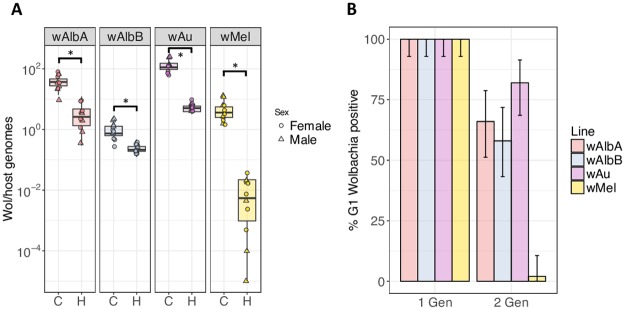
High temperature results in reduced Wolbachia densities and maternal leakage.(A) Larvae from the wAlbA, wAlbB, wAu, and wMel strains were reared at constant 27°C (C) or with temperature fluctuating between 27–37°C (12hours:12hours) (H) and assessed for Wolbachia density by qPCR upon adult emergence. Each point represents a pool of 3 adult mosquitoes. The centre of a box plot shows median Wolbachia density, edges show upper and lower quartiles, and whiskers indicate upper and lower extremes. Statistical analyses were performed using a two-tailed Student’s t-test. (B) Females reared under larval temperature cycling conditions were allowed to recover upon emergence at a constant 27°C and were crossed to wild-type males with infection rates in resulting progeny assessed (1 Gen). Females reared under heat treatment were mated with wild-type males, and resulting progeny were also reared under high temperature conditions—resulting in two consecutive generations of high temperature treatment. Infection rates were then assessed in the pupae resulting from the second round of larval heating (2 Gen). Error bars show binomial 95% confidence intervals.